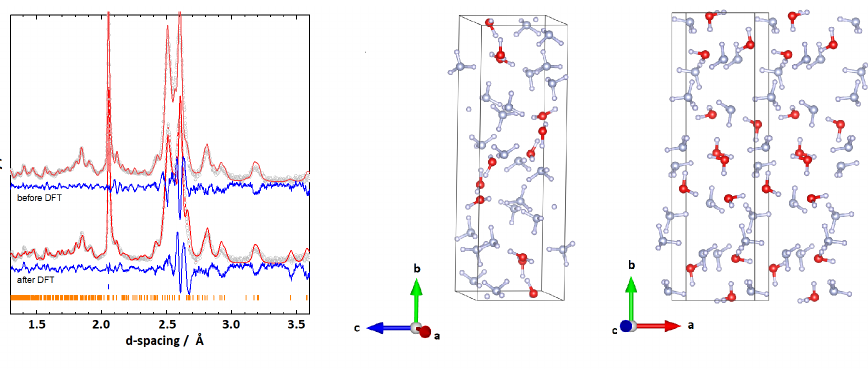
Figure 3. ( Left ): Rietveld fits to experimental data and respective structures for the monoclinic cell P2 1 / c (II) with a = 5.487 ( 3 ) Å, b = 19.068 ( 4 ) Å, c = 5.989 ( 3 ) Å, and β = 99.537 ( 16 ) deg. ( Right ): The model obtained from the Rietveld refinement. Data representation as explained in the caption of Figure